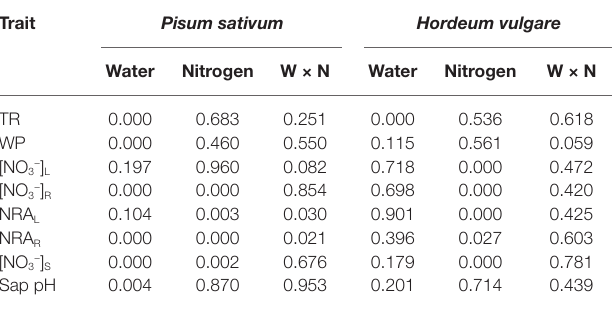
TABLE 3 | Significance of the experimental factors and their interaction was analyzed by two-way ANOVA.